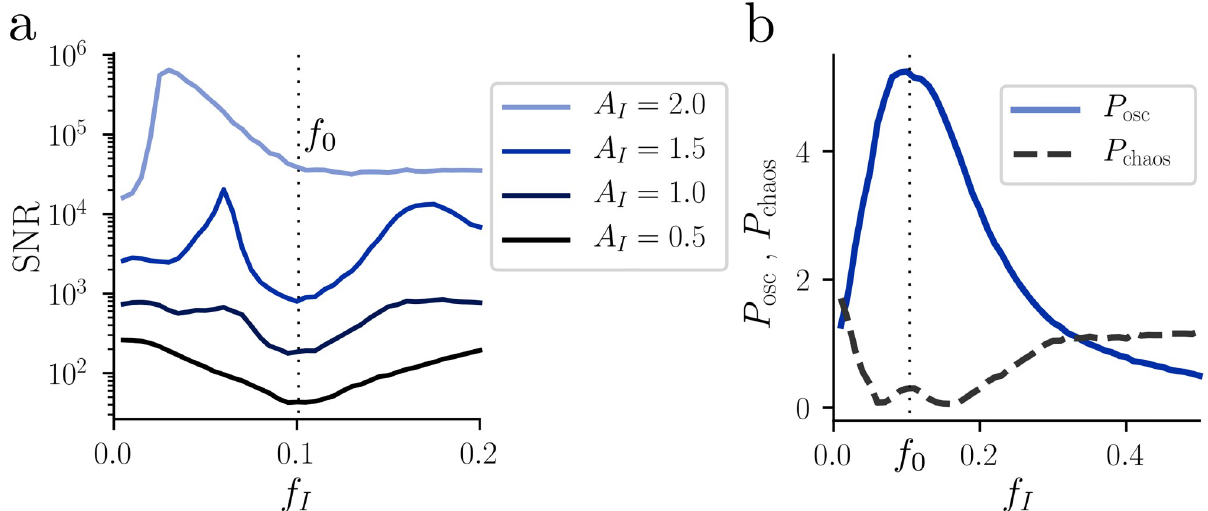
Fig 6. Effect of a strong oscillatory input. a: SNR at the driving frequency f I as a function of the driving frequency, for different values of the signal amplitude A I . As A I increases, nonlinear interaction between signal and noise become stronger, leading to a qualitative change in the SNR profile. b: Total power of the chaotic (black dashed) and oscillatory (light blue) components of the power spectrum, in the case of strong input ( A panels, γ = 0.25, β = 1.0, and g = 2 g c ( γ , β